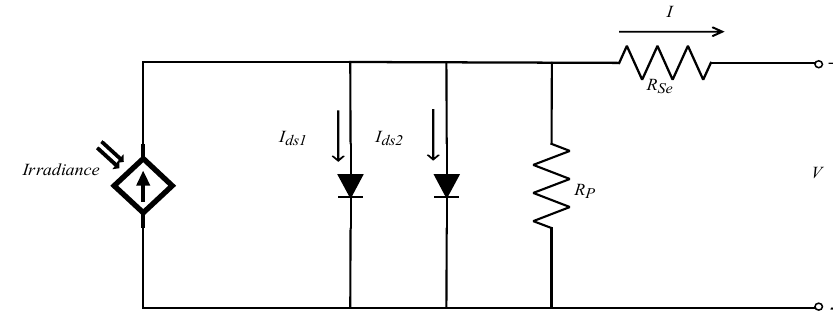
Figure 2. Equivalent circuit of the double-diode model.